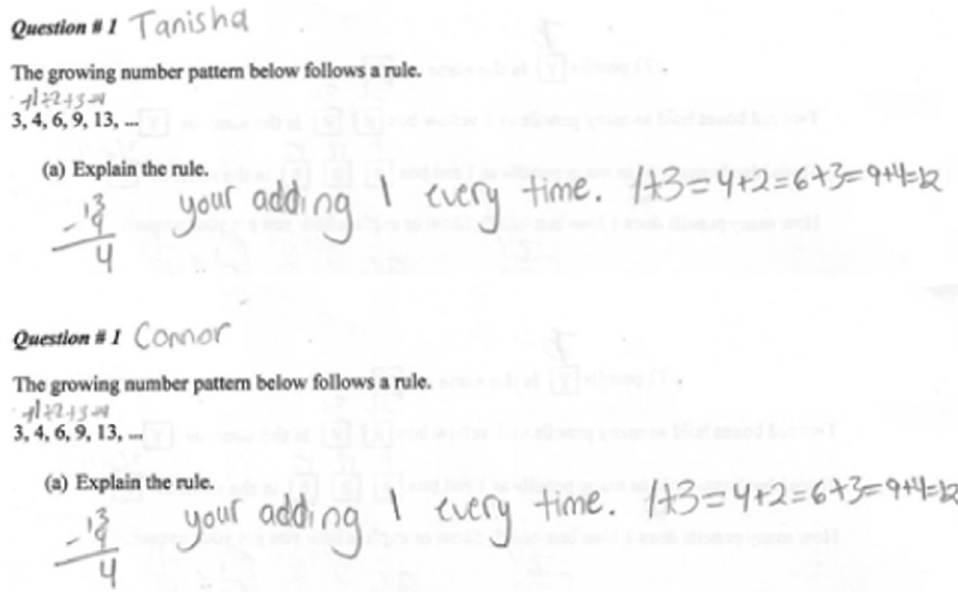
Fig. 1 A partially correct student solution assigned different